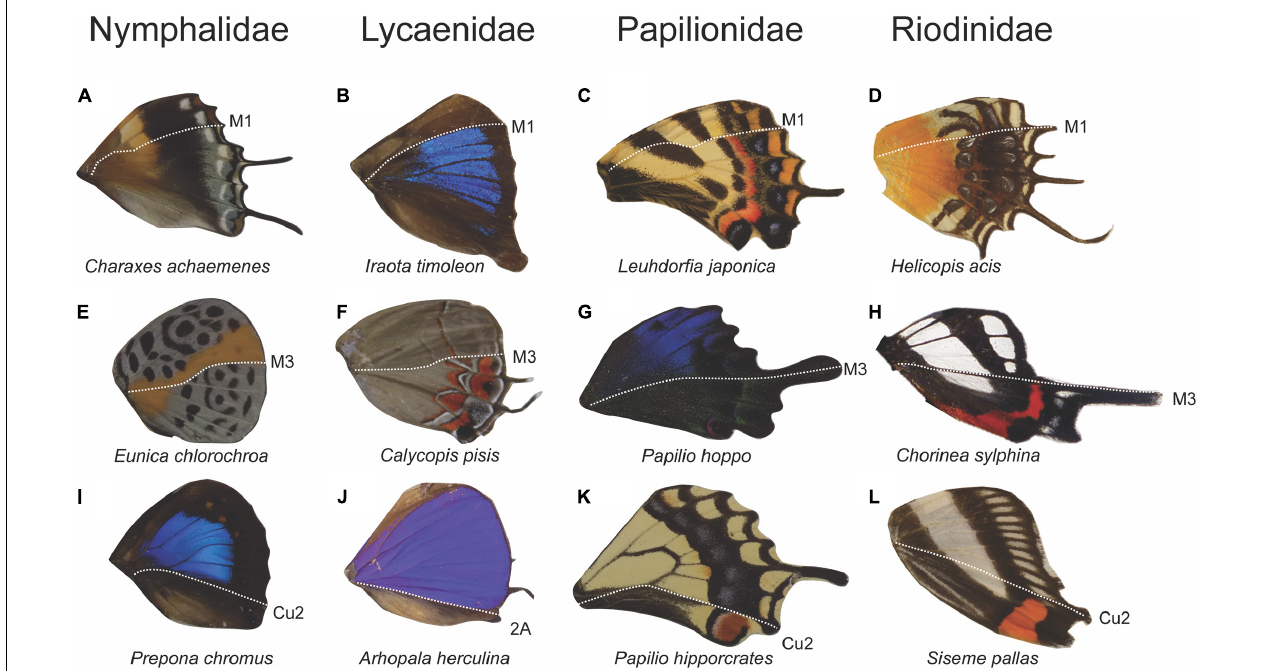
FIGURE 6 | Anterior–posterior color pattern heterogeneity in hindwings across four butterfly families. Wings show color pattern discontinuities at the M1 vein position (A–D) , at the M3 vein position (E–H) , and at the Cu2 or 2a vein position (I–L) . The occurrence of M1, M3, and Cu2/2a discontinuities across diverse taxa highlights the universality of an underlying anterior–posterior pattern formation mechanism on the wing ( Chorinea sylphina wing image obtained from Wikimedia Commons, https://commons.wikimedia.org/wiki/File:Chorinea_3.jpg).